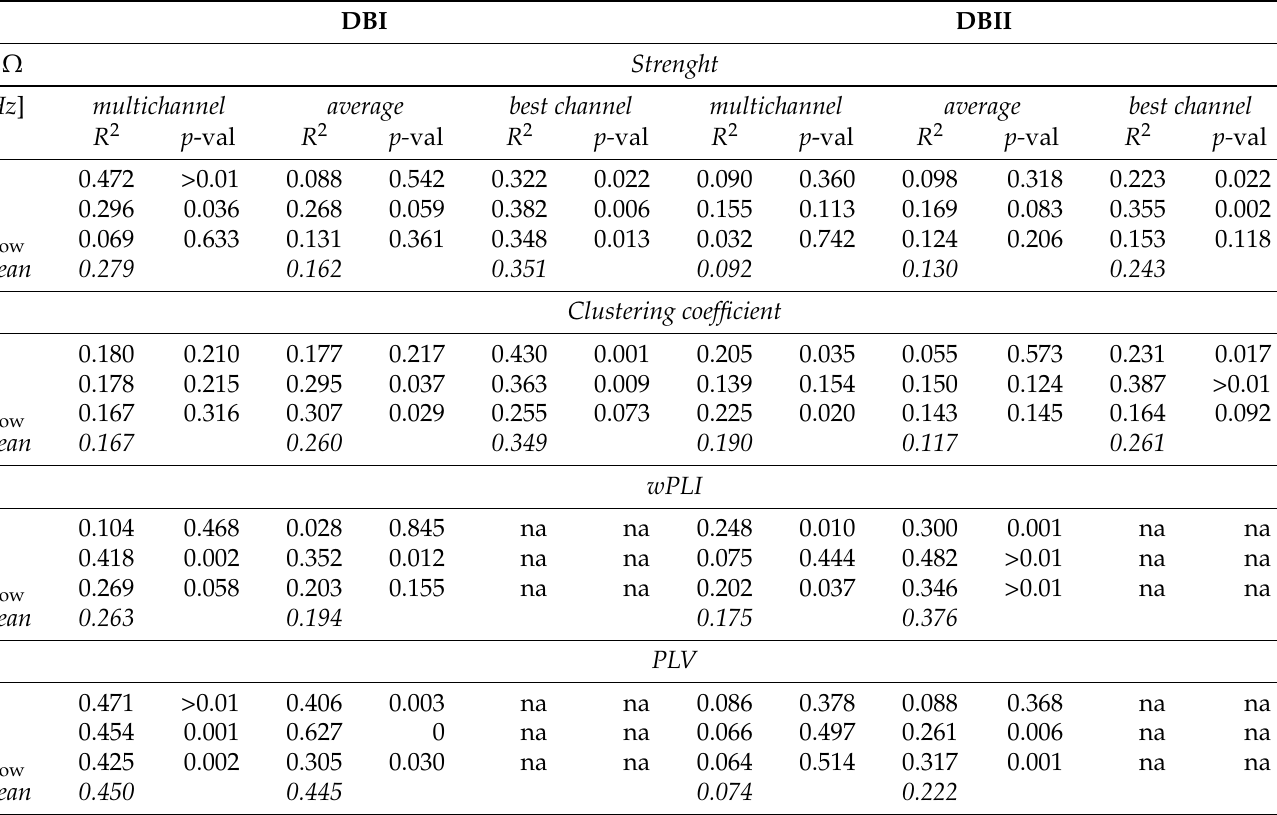
Table 1. Predicting performance of the FC predictors extracted from the resting-state data, employing the matrix indicator, the average, and the best index computed across the whole channel set. Notation mean stands for the indicator R 2 averaged across the frequency bands. Abbreviation na is not